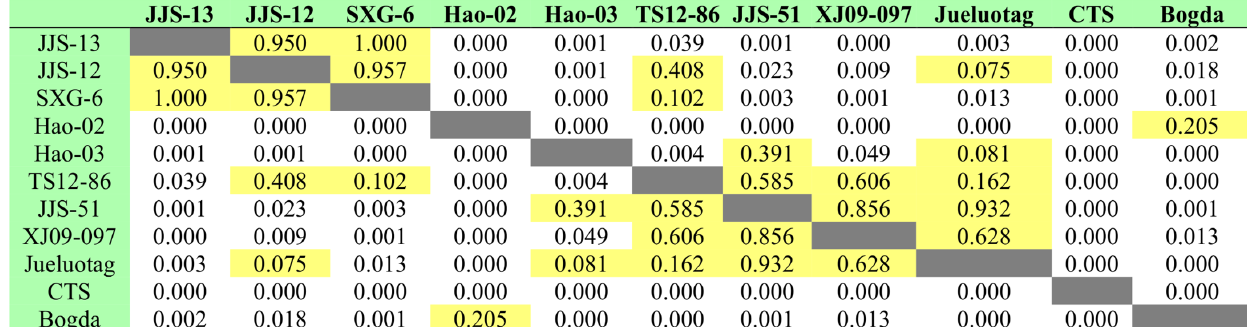
Figure 5. Relative probability map of U-Pb ages of Early Jurassic detrital zircons (data from [23,25,33,35,63]); for map locations, see Figures 1c and 3. Age spectra of potential-source-area fea- tures (data from [64,65,68,74] and references therein).